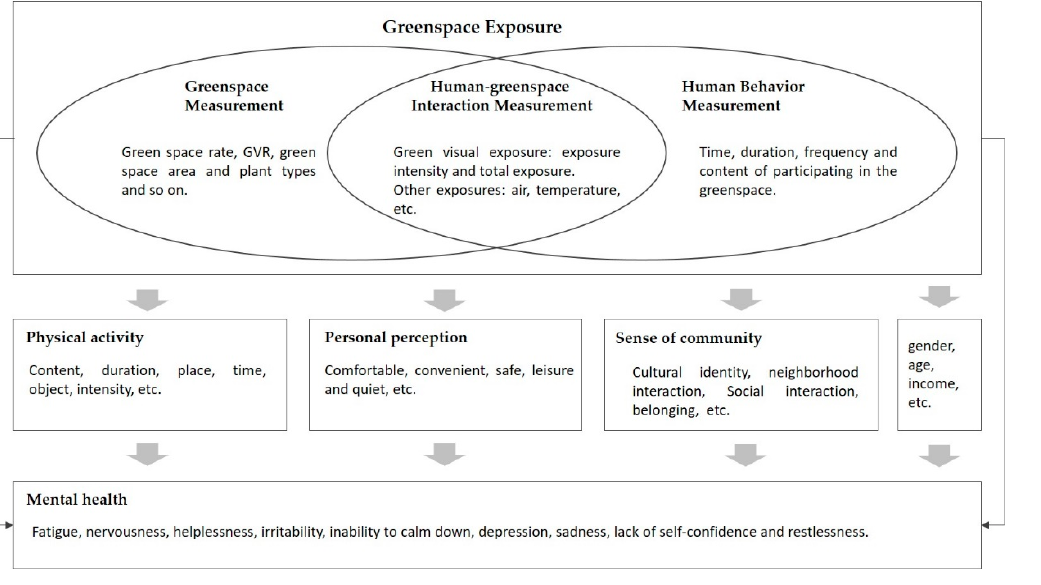
Figure 1. Conceptual framework.